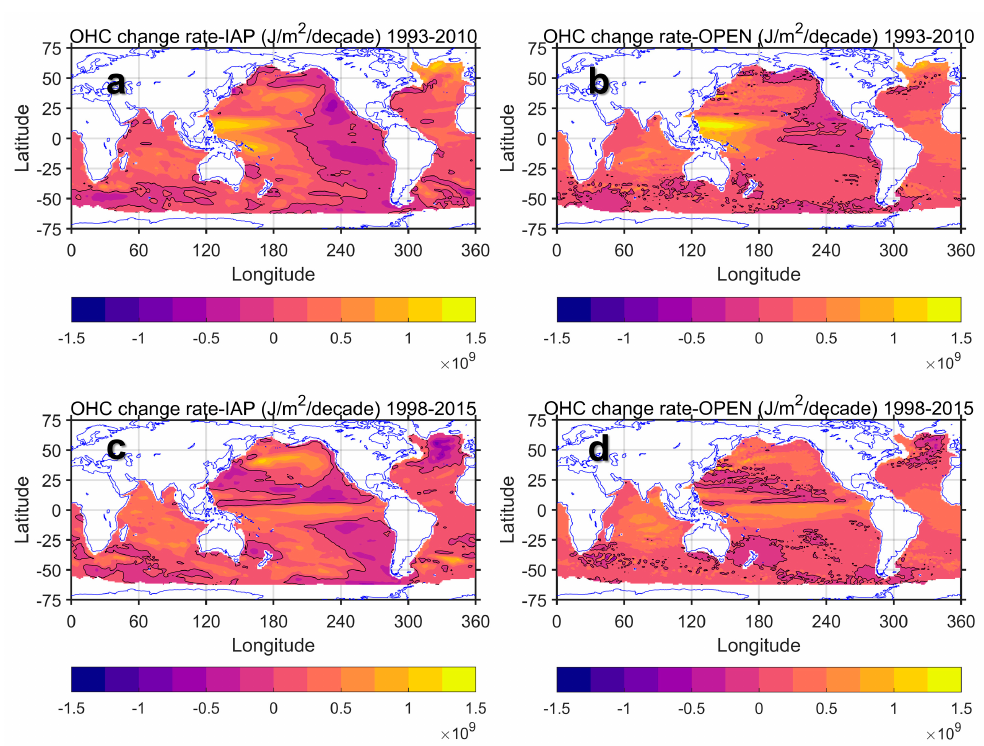
Figure 6. The warming trends of the ( a,c ) IAP and ( b,d ) OPEN OHC300 in ( a,b ) 1993–2010 and ( c,d ) 1998–2015. Black contours are zero values.